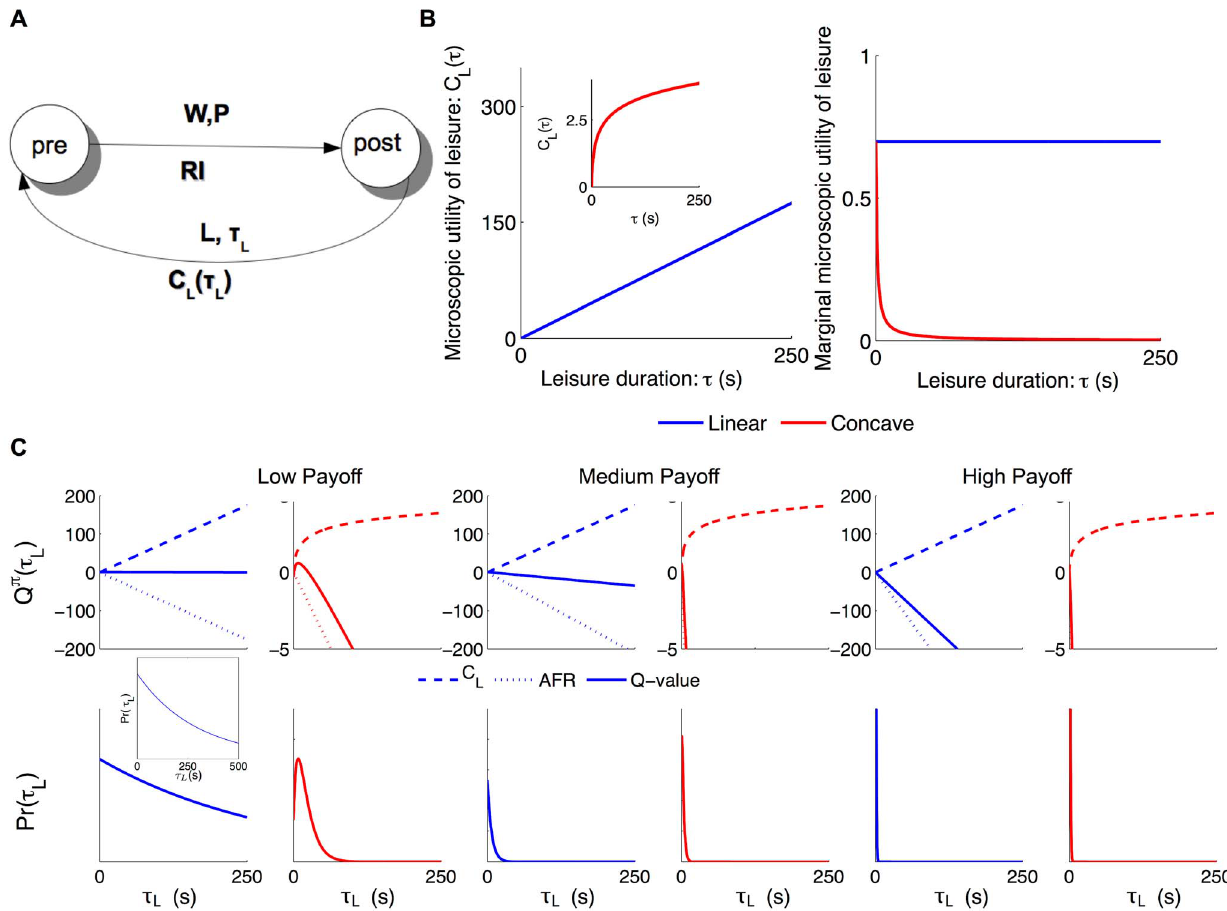
Figure 3. Micro SMDP model, microscopic utilities of leisure and policies. A) The infinite horizon Micro semi-Markov decision process (Micro-SMDP). States are characterised by whether they are pre- or post-reward. Subjects choose not only whether to work or to engage in leisure, but also for how long to do so. For simplicity, we assume that a subject pre-commits to working for the entire price duration when it works. Then it receives a reward of reward intensity RI and transitions to the post-reward state. In the post-reward state, by choosing to engage in leisure for a duration t L , it gains a microscopic benefit of leisure C L ( t L ) and then returns to pre-reward state; this cycle repeats. B) Left: canonical microscopic utility of leisure functions C L ( : ) , right: the marginal microscopic utility of leisure. For simplicity we considered linear C L ( : ) (blue); whose marginal utility is constant and concave (here logarithmic) C L ( : ) (red) whose marginal utility is always decreasing. C) Q -values and policies for engaging in leisure for low, medium and high payoffs. In upper panels, dashed, dotted and solid curves show: C L ( : ) , AFR and Q -values,